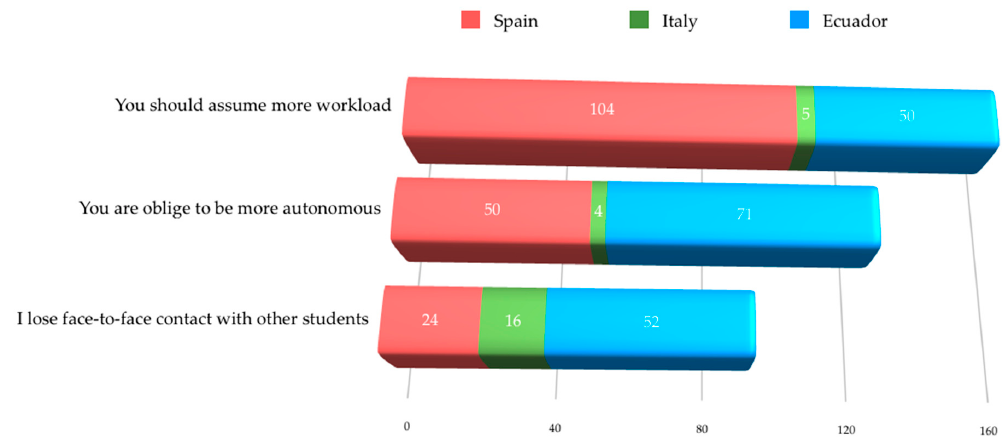
Figure 1. Student general perception about the learning situation during the lockdown among countries.